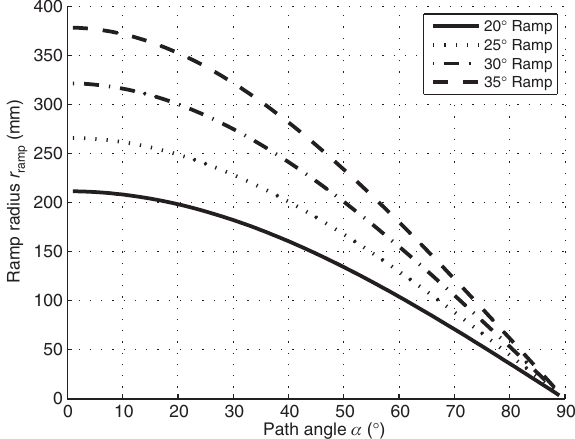
Figure 13 Required ramp radius as function of path angle for differ- ent ramp